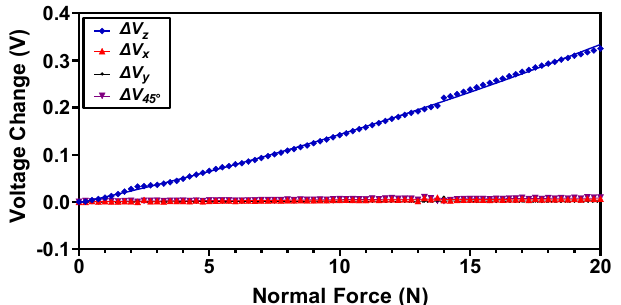
Figure 11. The output voltage response of the proposed magnetic tactile sensor for an applied nor-